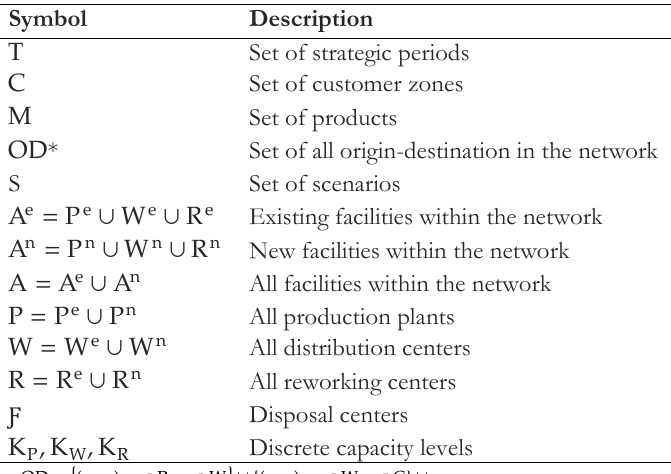
Table 2. Sets and